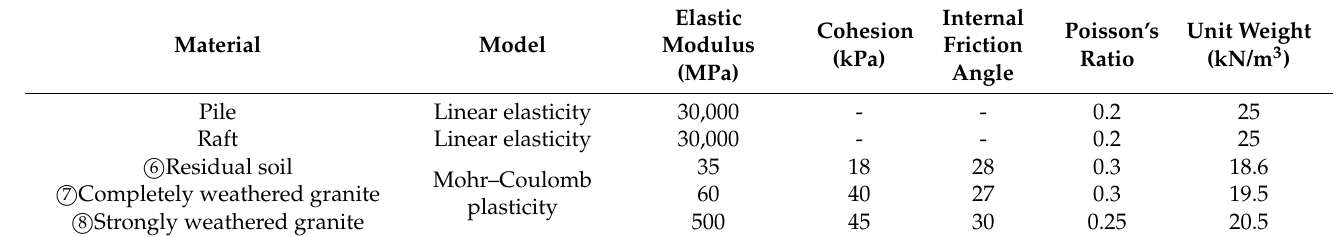
Table 2. Model parameters.